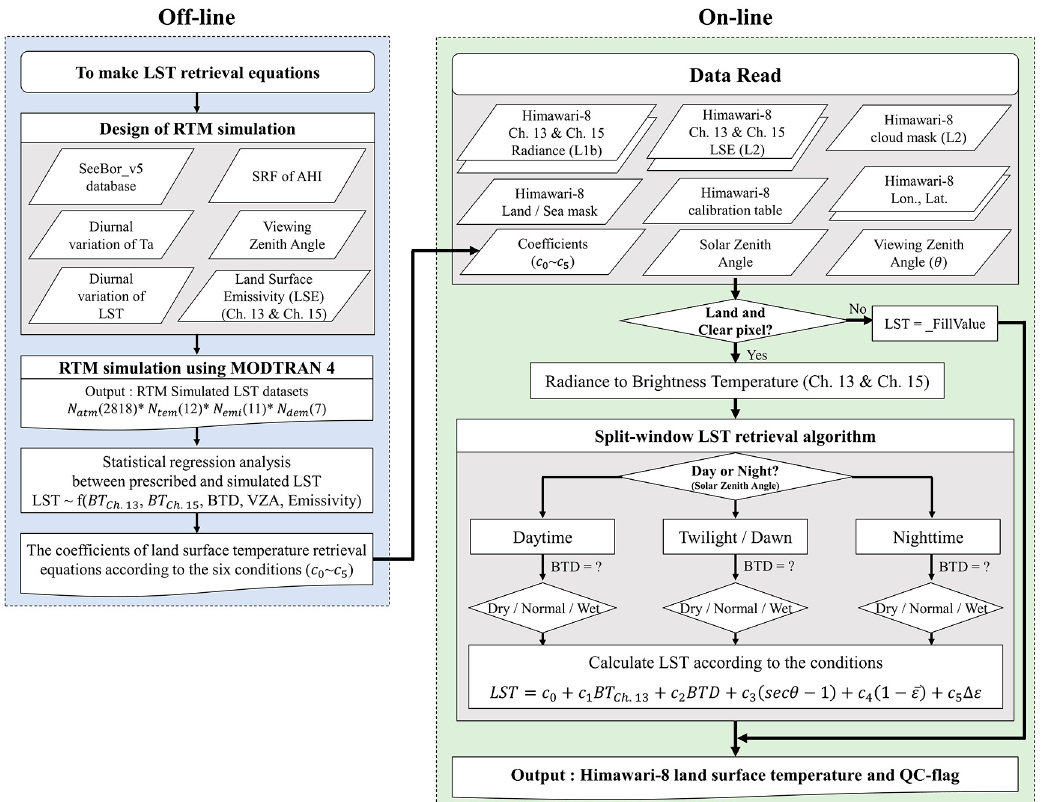
Figure 3. Flowchart of LST retrieval process from Himawari ‐ 8/AHI.